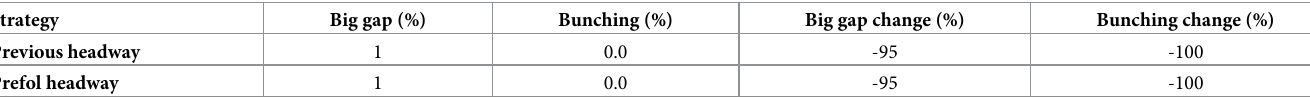
Table 14. Effect of holding strategies on big gap and bunching.